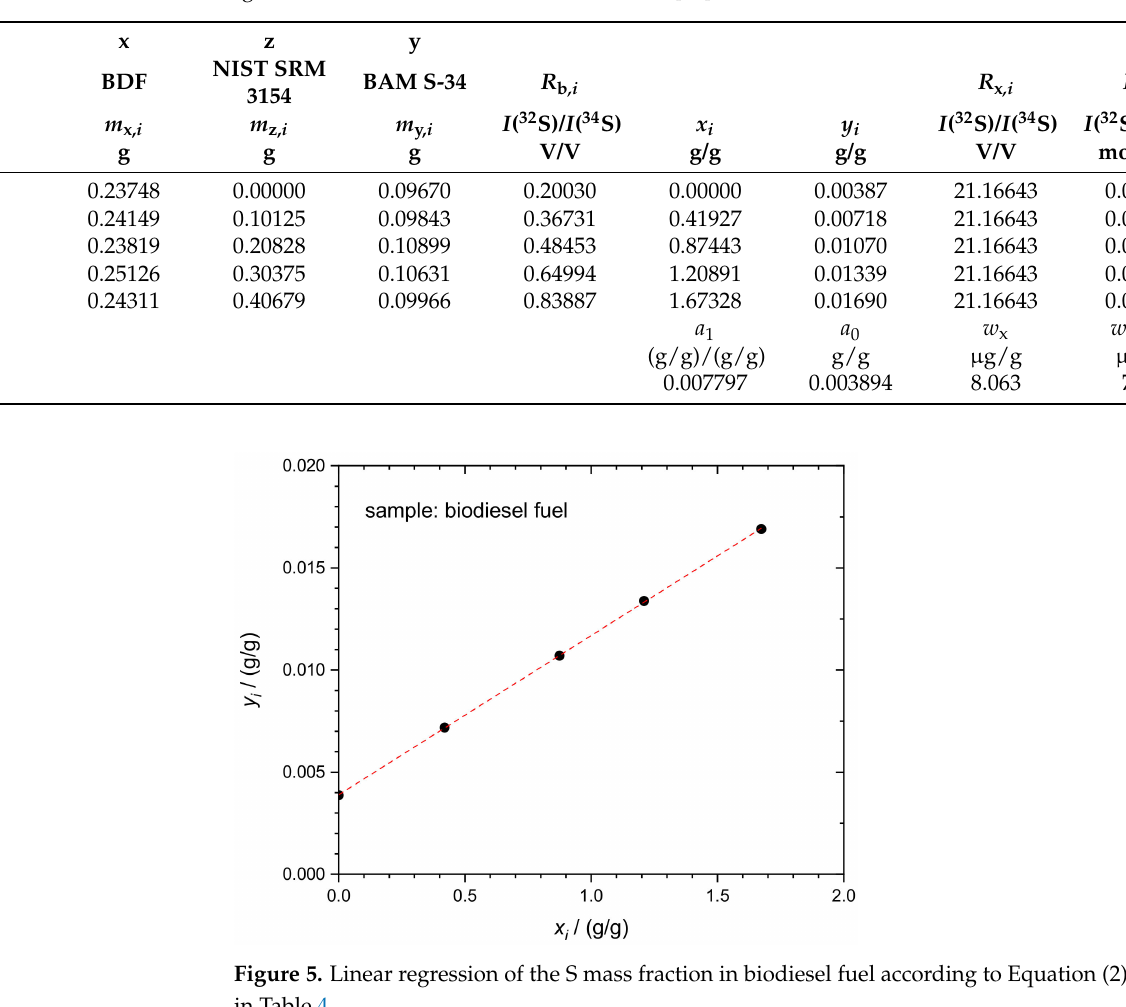
Table 4. Determination of w x in BDF. The relevant input and output data of linear regression analysis are given for a single representative dataset (1st run), with w z = 16.145 µ g/g. A procedural blank was subtracted from the result. The procedural blank was determined during an external measurement, as described in [23].